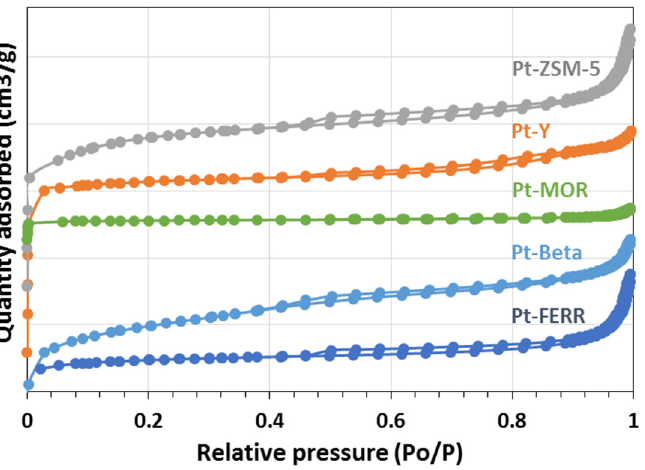
Figure 2. The nitrogen isotherms of the prepared Pt-incorporated zeolite materials (Y, Beta, MOR, FERR, and